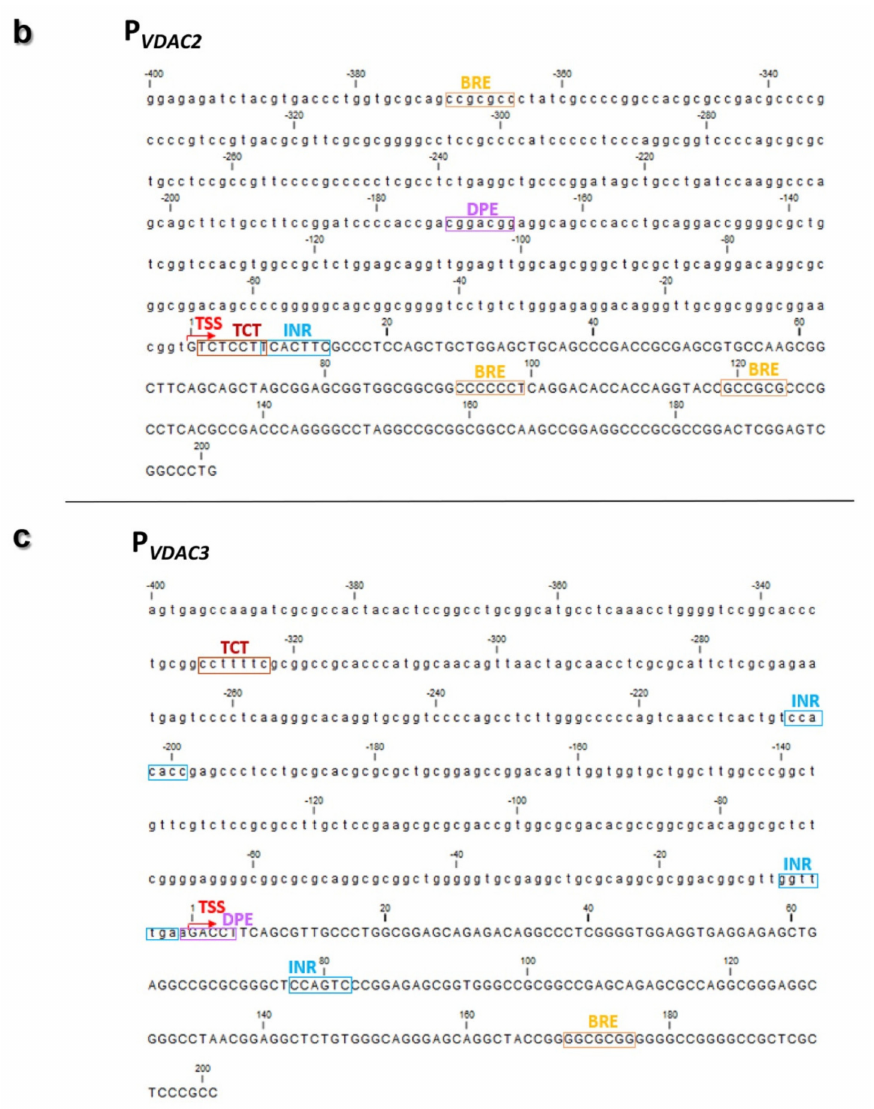
Figure 5. Canonical core promoter elements of human VDAC gene isoforms. The results of core promoter elements identified for hVDAC1 , hVDAC2 , and hVDAC3 genes by predictive tools are the sequence stretches with a high scoring consensus based on position weight matrix (PWM). ( a ) P VDAC1 (chr5:133,340,230-133,340,830; hg19) encompassed an Inr element (at − 261 bp), two GC-boxes (at − 85 bp; − 49 bp), five B recognition element (BRE) motifs (at − 255 bp; − 217 bp; − 78 bp; − 42 bp; − 27 bp), and two downstream promoter element (DPE) motifs (at − 298 bp; − 266). ( b ) P VDAC2 (chr10:76,970,184-76,970,784; hg19) a Polypyrimidine initiator (TCT) motif, as an alternative Inr (at + 2 bp), Inr element (at + 8 bp), two BRE motifs (at + 93 bp; + 119 bp), a DPE motif (at − 173 bp). ( c ) P VDAC3 (chr8:42,248,998-42,249,598; hg19) encompasses three Initiator element (Inr) elements (at − 205 bp; − 8 bp; + 77 bp), a TCT (at − 329 bp), a DPE (at − 1 bp) and a BRE (at + 170 bp). TSS site is indicated by a red arrow. Nucleotide